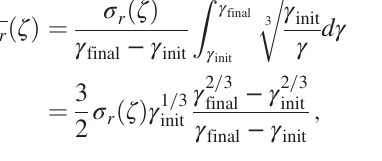
TABLE I. Charge and energy gain of the witness bunch, and driver-to-witness efficiency as a function of the witness head position. Values are computed assuming a background plasma density n 0 ¼ 5 × 10 17 cm − 3 . The driver parameters are the same ¼ 1 . 5 nC and E − ¼ 34 GeV = m. as in Sec. II, yielding Q d d ζ k Q [pC] E þ [GeV/m] η [%] w p w head − 10 .